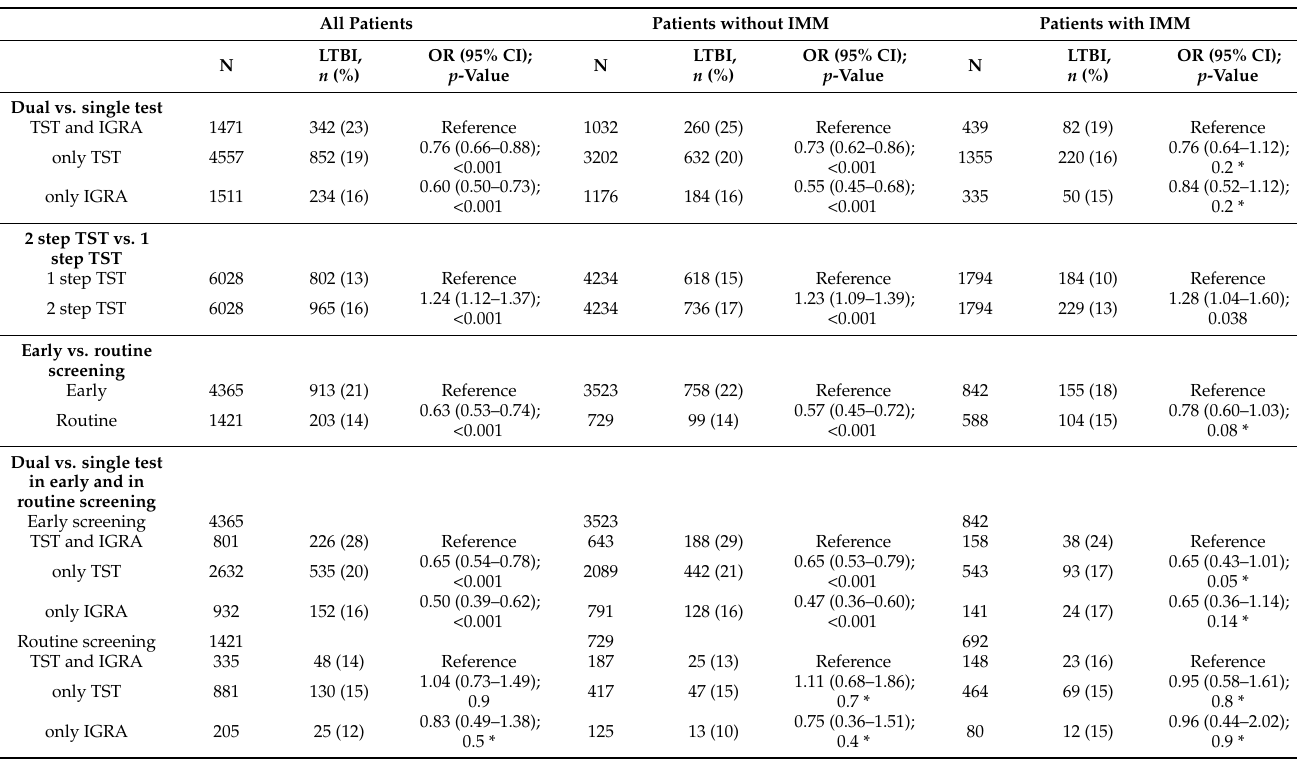
Table 4. Performance of screening strategies for the diagnosis of LTBI in patients with